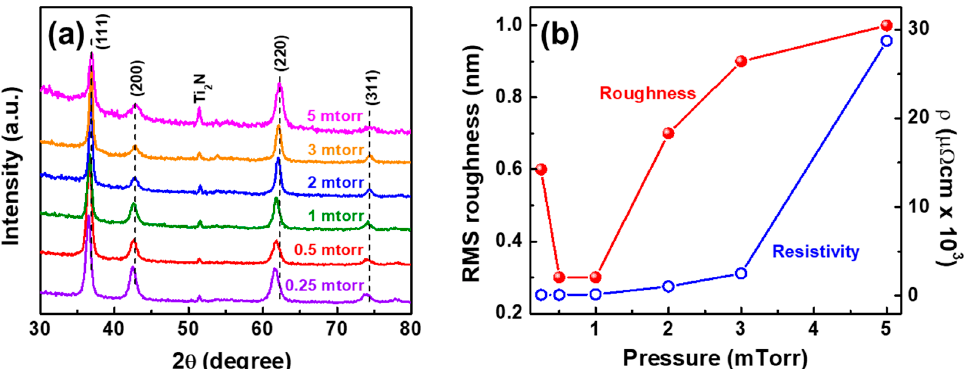
Figure 5. ( a ) XRD pattern, ( b ) RMS roughness (R q ) and resistivity of TiN thin film on the Si/SiO 2 <100> substrate with various working pressure.